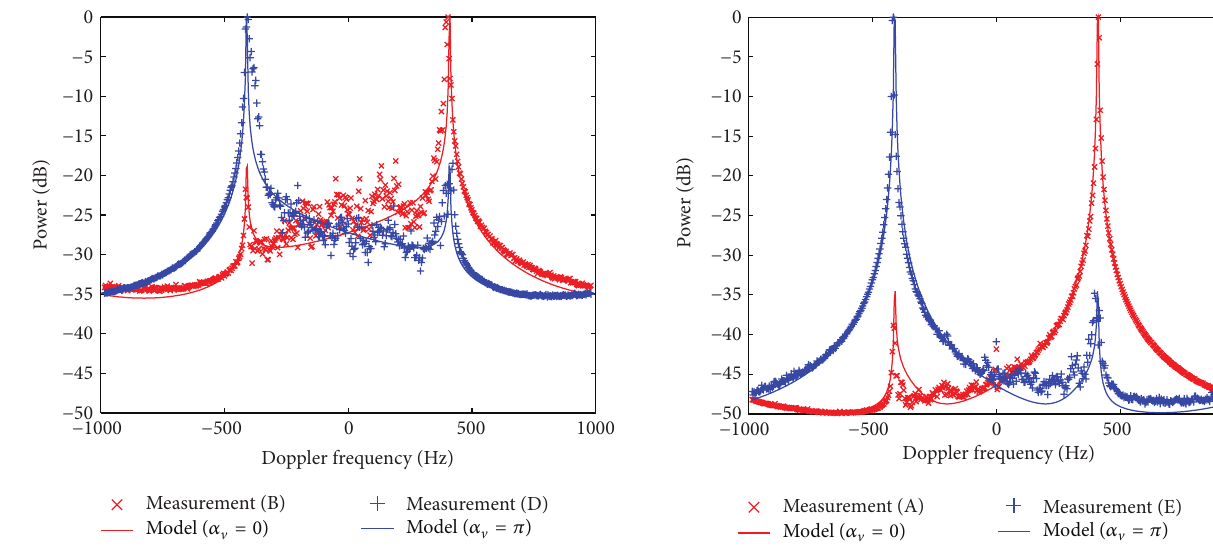
Figure 9: Doppler PSDs of the measurement and the proposed model for the unobstructed environment (𝛿 𝑇 = 𝛿 𝑅 = 0)